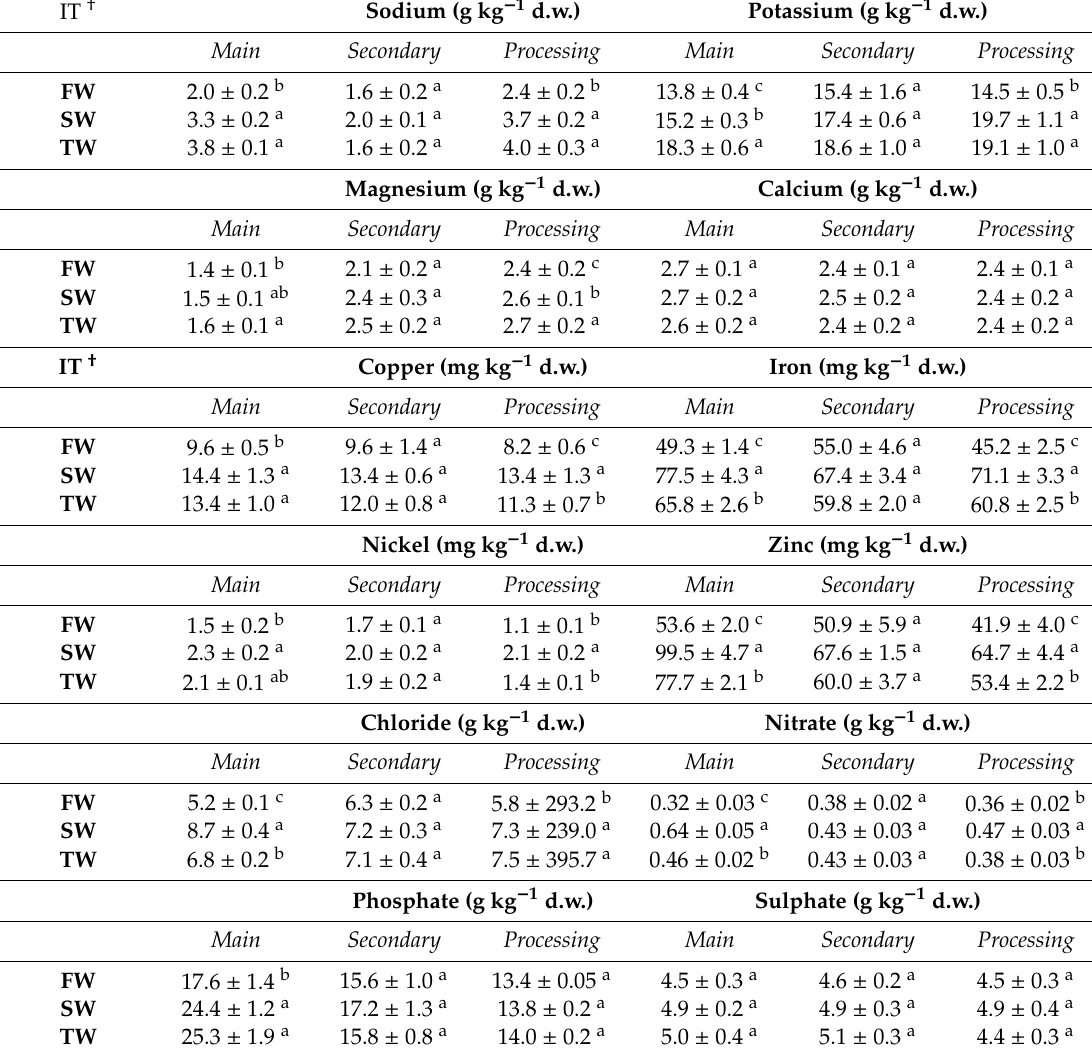
Table 2. E ff ects of water irrigation treatments (IT) on mineral profile of artichoke head. IT